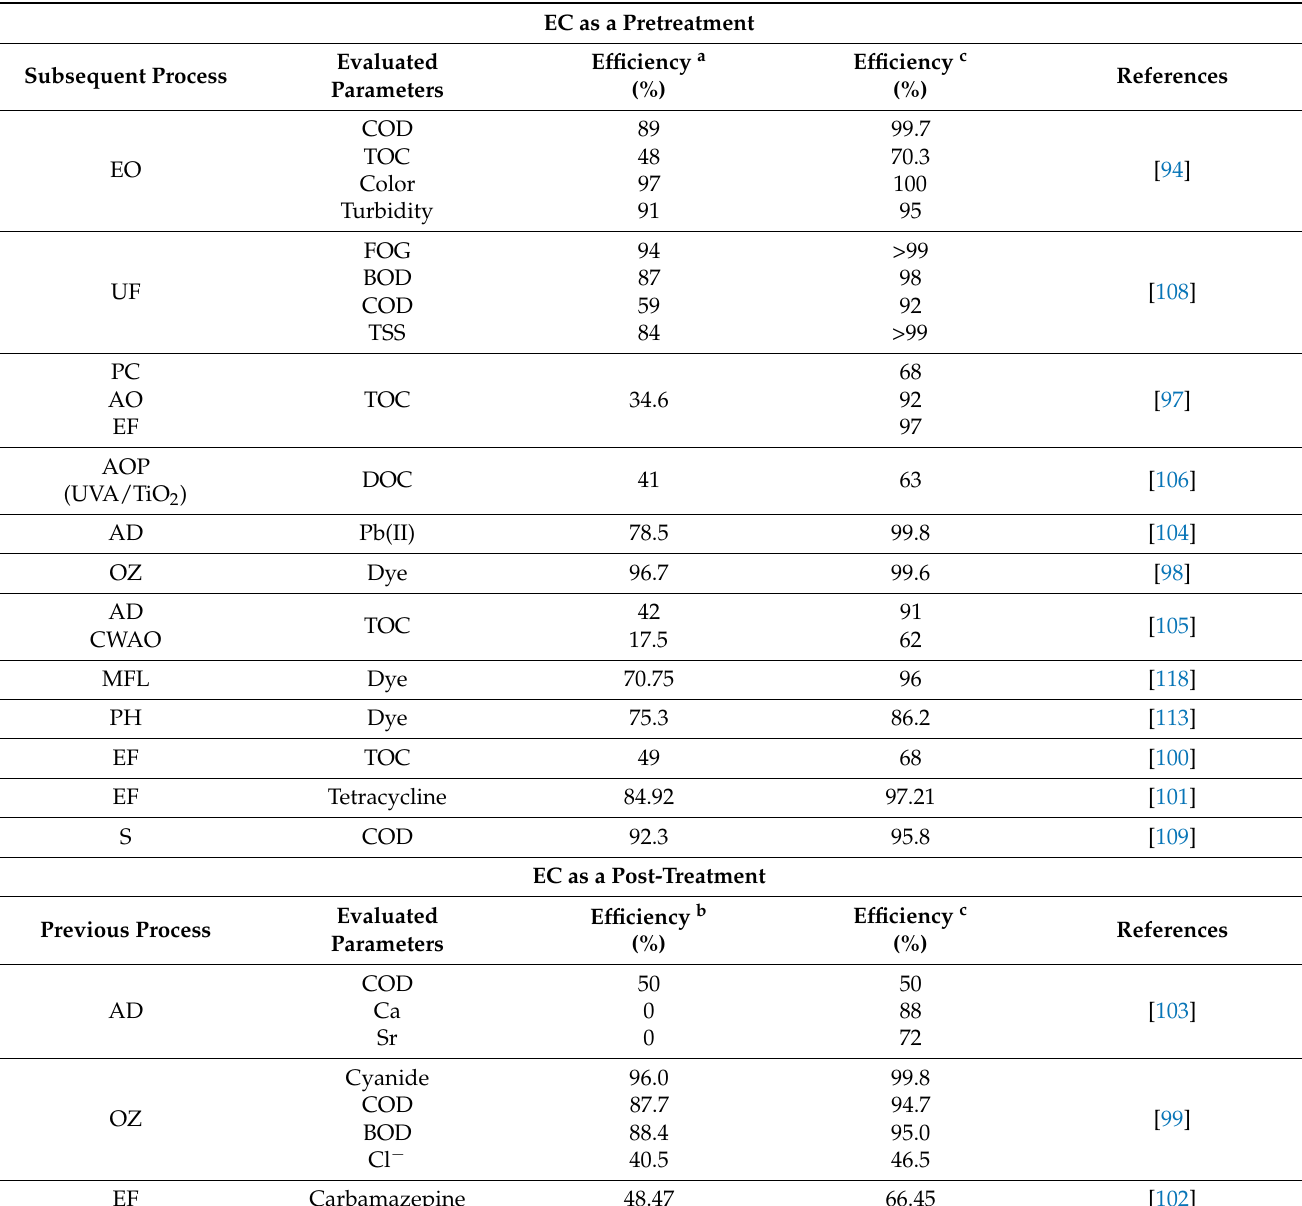
Table 3. Hybrid processes and efficiency improvement with the electrocoagulation process as pre-treatment or